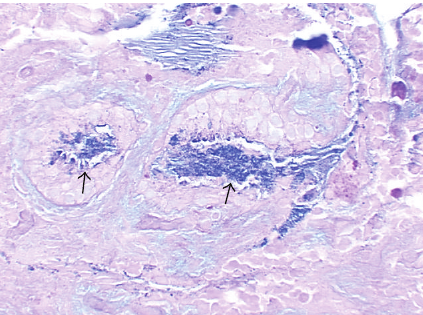
Figure 1: Mucous cell metaplasia/hyperplasia is identified with AB- PAS stain in a piece of middle ear mucosa (from a chronic OM patient) which contains abundant mucous cells (arrows, deep blue areas) and accumulated mucin glycoproteins in the central area of the gland-like structures. Amplification, ×